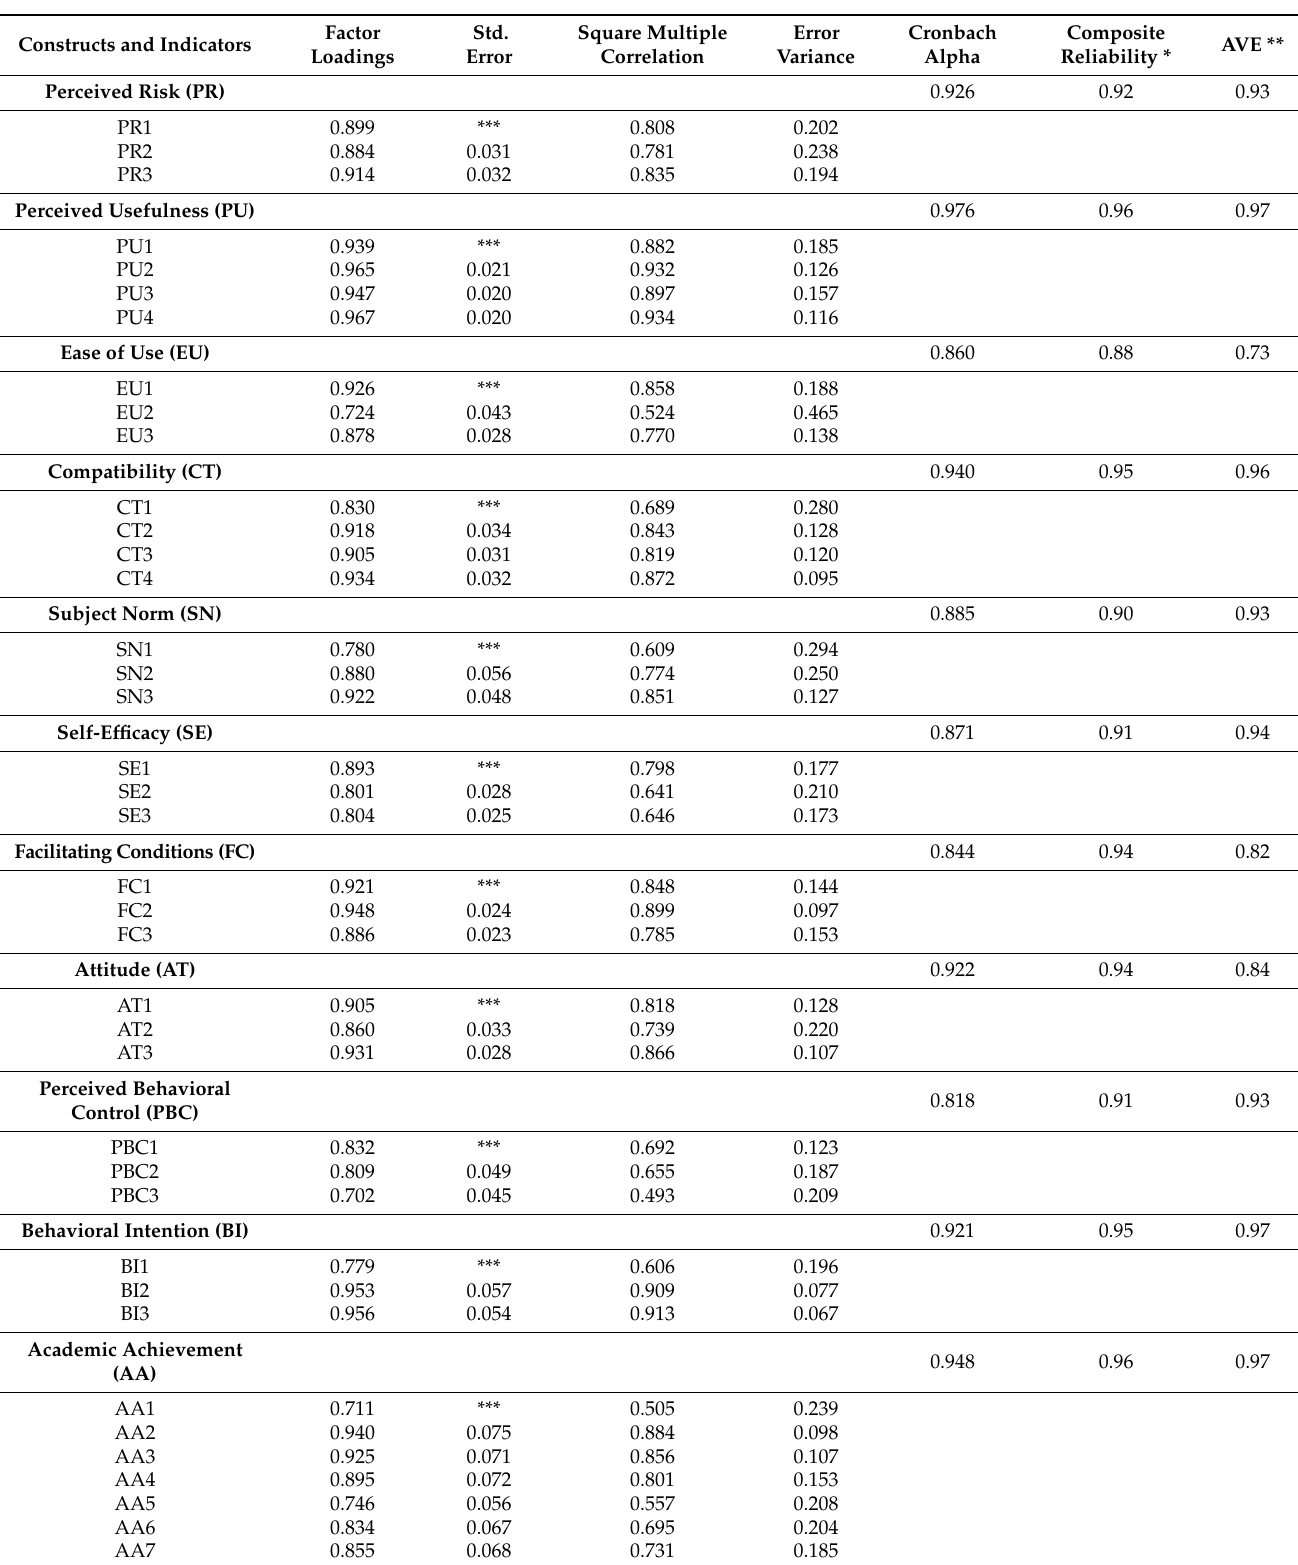
Table 5. Properties of the final measurement